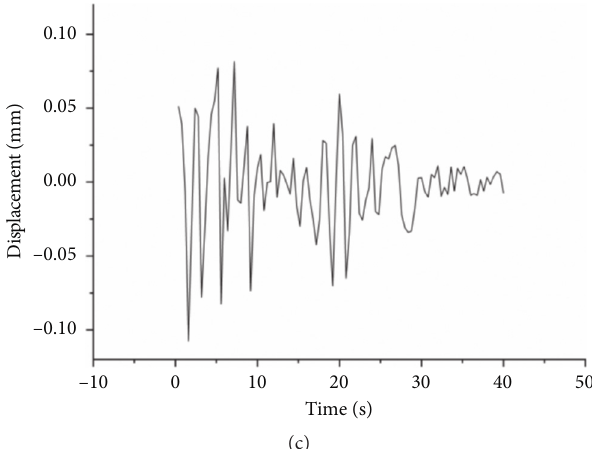
Figure 10: Time history of the El Centro wave. (a) Lateral acceleration-time curve. (b) Lateral velocity-time curve. (c) Lateral displacement- time curve.